Question: Briefly state, in one sentence, what is plotted here.
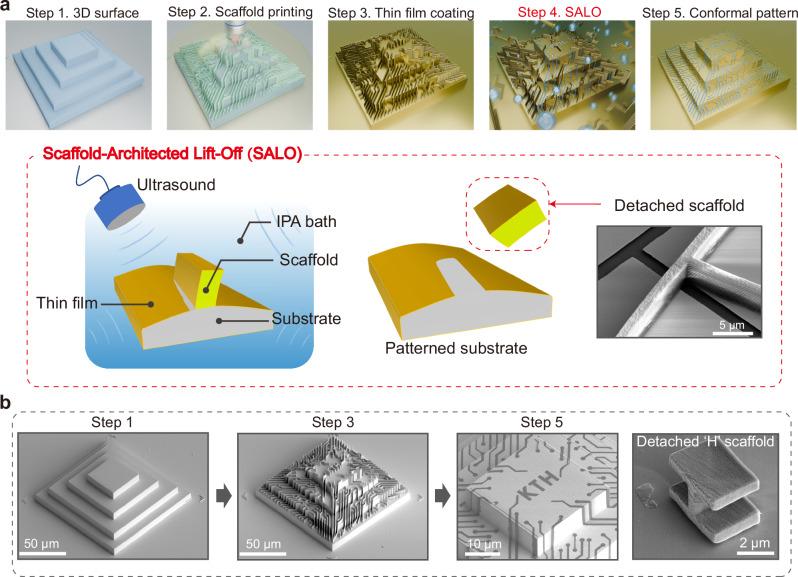
Answer: Scaffold-architected lift-off (SALO) process. a Schematic illustration of the SALO process steps (upper panel). Steps 1 and 2: Printing of the polymer scaffold structures by TPP. Step 3: Conformal thin-film coating of the surface. Step 4: Sonication to initiate scaffold lift-off. Step 5: Final pattern after SALO. In the SALO process (Step 4), the scaffold with the thin-film coating is selectively lifted off in an isopropanol bath (lower panel). The sonication causes cavitation-induced microjets and shockwaves that facilitate the mechanical detachment of the scaffold, leaving the defined pattern on the underlying surface. b SEM images of samples at each of the key SALO process steps. The 3D substrate and the scaffold structures were fabricated using TPP printing, demonstrating high-resolution patterning on complex 3D topographies.